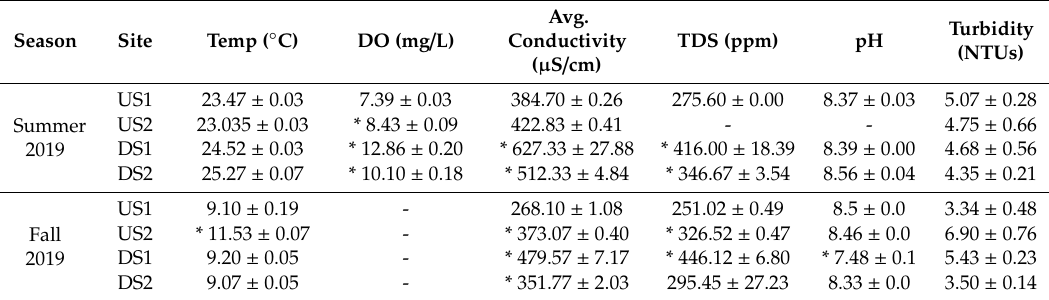
Table 1. A summary of the water conditions during the sampling of fishes. Data are presented as mean ± standard error of the mean (SEM; n = 3 per site). Water quality measurements were taken on the same day as the sampling at that site where fish were collected from. Total dissolved solids (TDS) and pH in summer 2019 and dissolved oxygen (DO; mg / L) measurements from fall 2019 were unavailable due to instrument calibration issues on the day of sampling. An asterisk indicates a significant di ff erence in concentration compared to US1 (Dunnett’s multiple comparisons test, p < 0.05). NTUs, nephelometric turbidity units; US1, upstream 1; US2, upstream 2; MWWTP, municipal wastewater treatment plant; DS1, downstream 1; DS2, downstream 2.